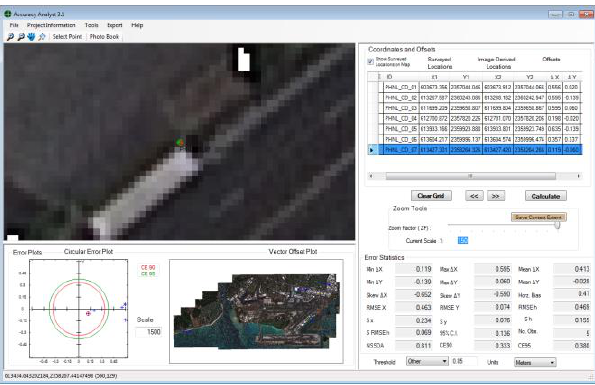
Figure 5: Verification with CompassAA